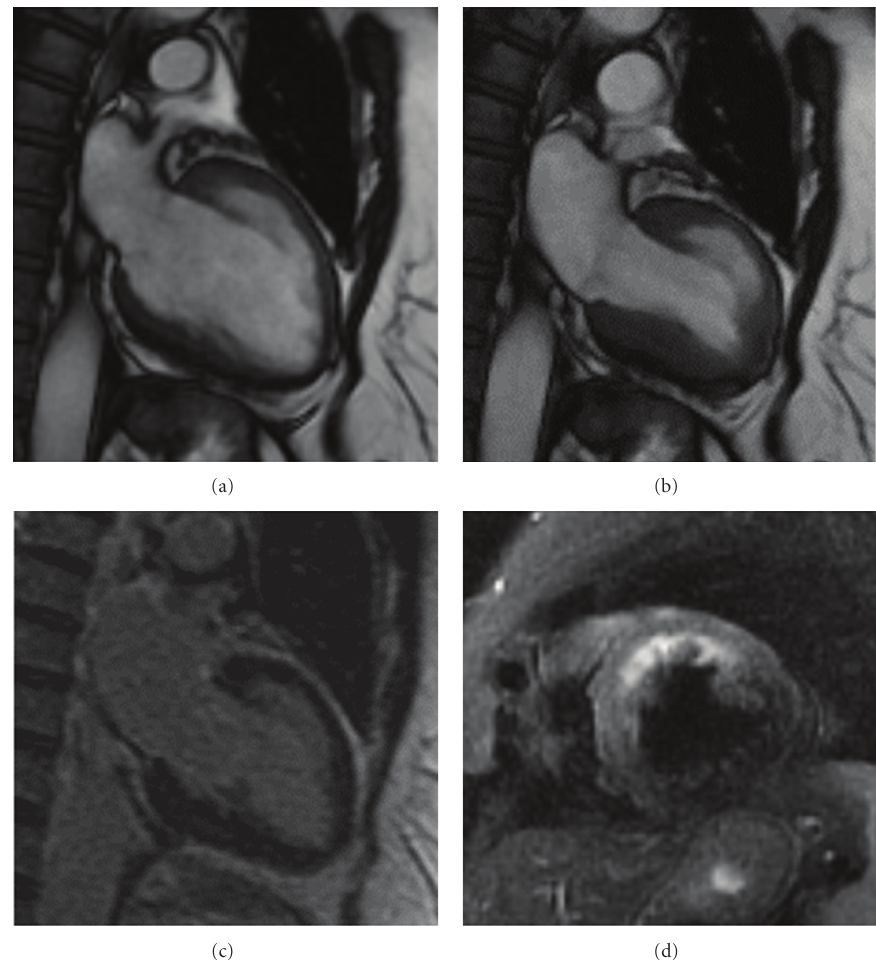
Figure 2: Cardiac magnetic resonance imaging. Enddiastolic and endsystolic 2-chamber view (upper row). Late enhancement 2-chamber view lower left. Anteroseptal edema in the T2 STIR short-axis view (lower